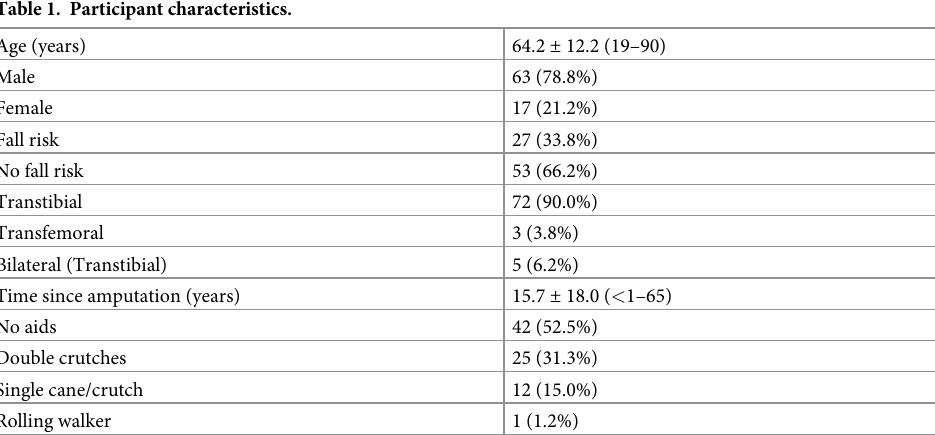
Table 1. Participant